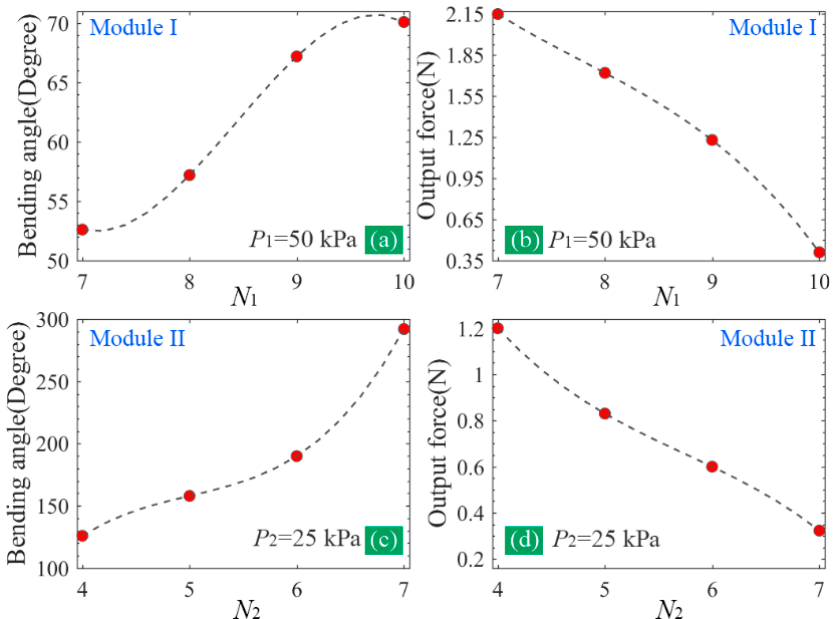
Figure 4. ( a , b ) The influence of the chamber number ( N 1 ) on the bending angle and output force of module I and ( c , d ) the influence of the chamber number ( N 2 ) on the bending angle and output force of module II.